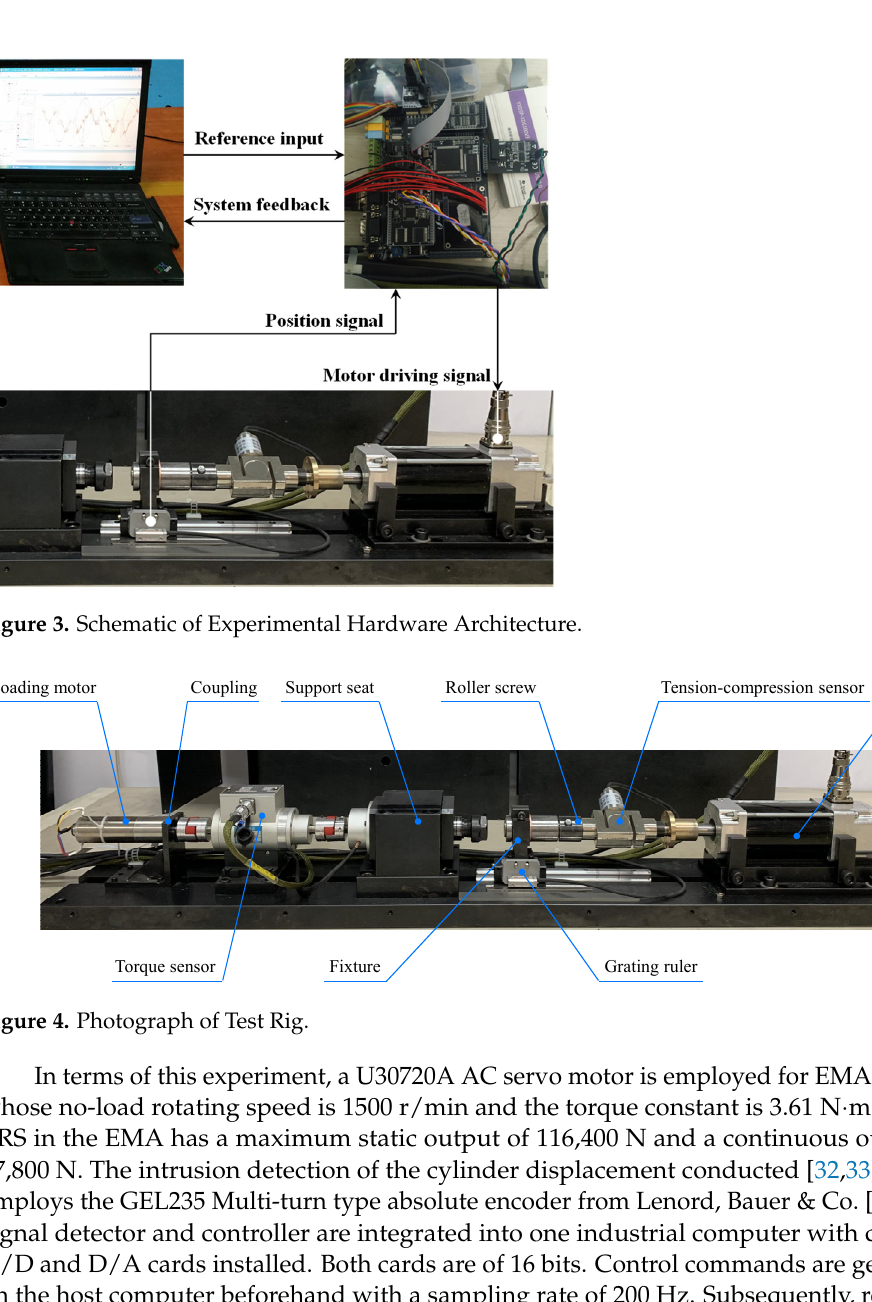
Figure 4. Photograph of Test Rig.